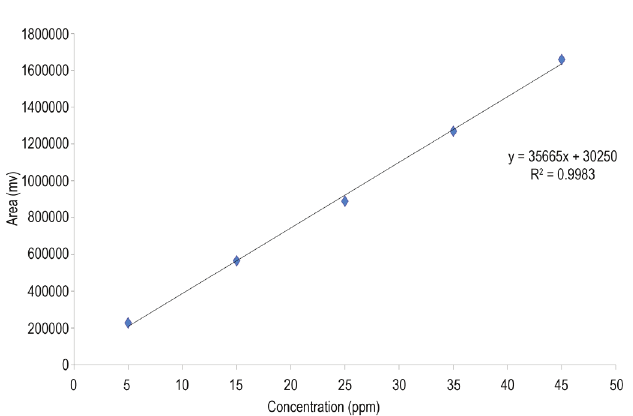
FIGURE 1 - Calibration curve of standard γ-oryzanol.